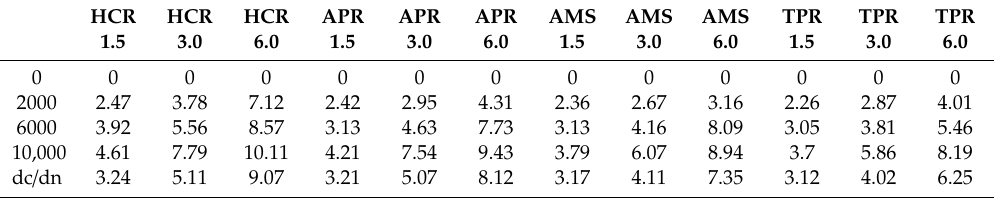
Figure 5. Mechanical properties of rubber composites: ( a ) Akron abrasion of the rubber composites with varying content fractions of di ff erent resins, ( b ) Lamborn abrasion of the rubber composites with varying content fractions of di ff erent resins, ( c ) William abrasion of the rubber composites with varying content fractions of di ff erent resins, and ( d ) Fatigue properties of the rubber composites with varying content fractions of di ff erent resins. Table 4. Fatigue properties of rubber composites with varying content fractions of di ff erent